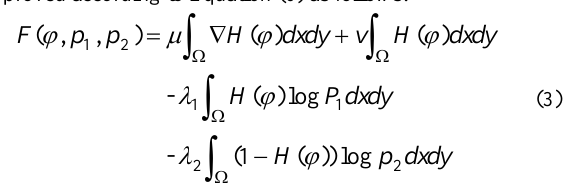
Figure.1 Basic framework of proposed